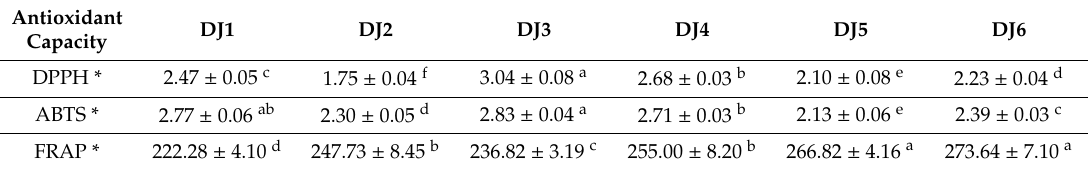
Table 3. Antioxidant activities in di ff erent ‘Duoju’.